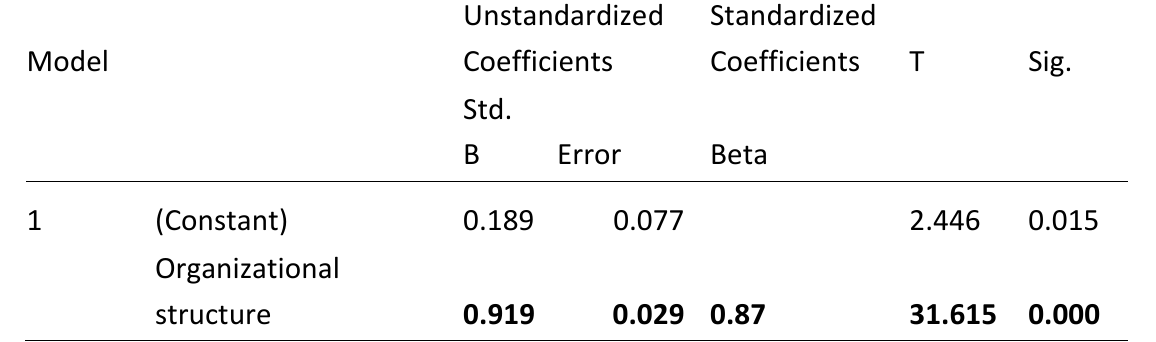
Table 6. Regression of